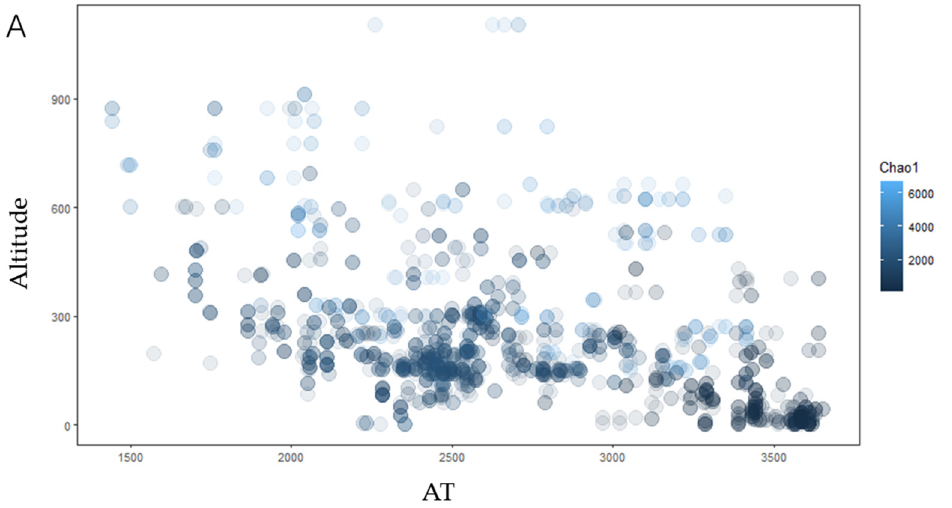
Figure 8. Comparison of the distribution of soil bacterial abundance under the conditions of altitude and accumulated temperature ( A ), and pH and soil organic matter ( B ). The darker the color of bubbles, the higher the Chao1 index. ( A ) Altitude (m), AT (°C); ( B ) SOM (g/kg). 5. Conclusions In conclusion, our study provides a map of soil bacterial abundance distribution in the black soil region of Northeastern China. It quantified the spatial effect of soil bacterial abundance in the cultivated land in the black soil region using dbMEM analysis and iden- tified the influencing factors of soil bacterial abundance. This study found the following: (1) broad (8.336%), AT (5.520%), and pH (4.184%) were the main factors affecting the dis- tribution of soil bacterial abundance in the black soil area; (2) in terms of spatial effects, broad scale (148–222 km, 8.336%) > medium (74–148 km, 0.443%) > fine (30–74 km, 0.368%); (3) the influencing factors of soil bacteria in different regions were not consistent and the cultivated land in mountainous areas had a higher degree of explanation than that in plain areas. Our research shows that the influencing factors of soil bacteria are related to regional characteristics. Therefore, when considering the differences in cultivated land quality in different regions, we should fully consider the regional spatial heterogeneity and land- scape configuration, which are closely related to human activities, in order to provide a